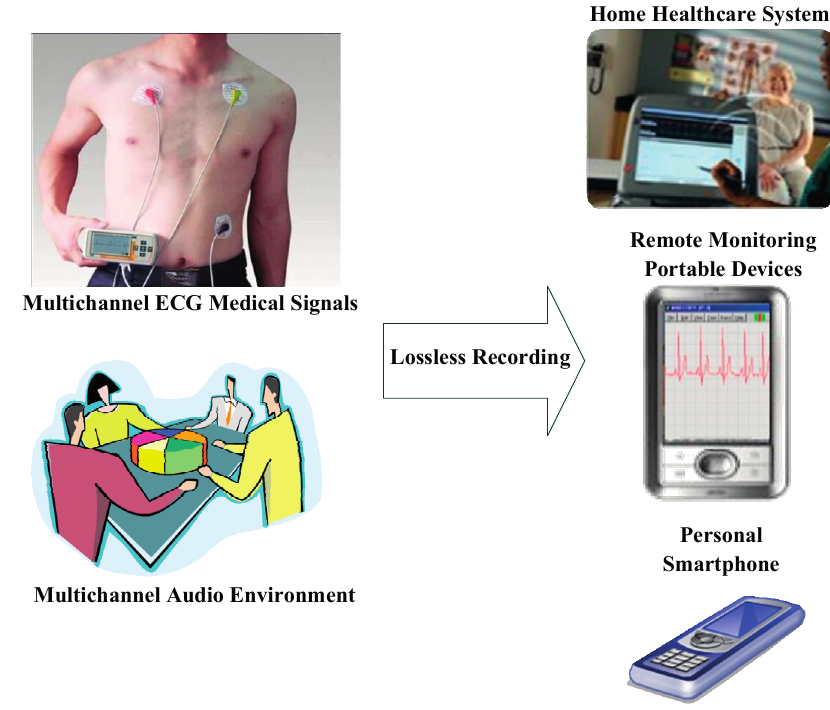
Figure 1. Consumer products for multichannel